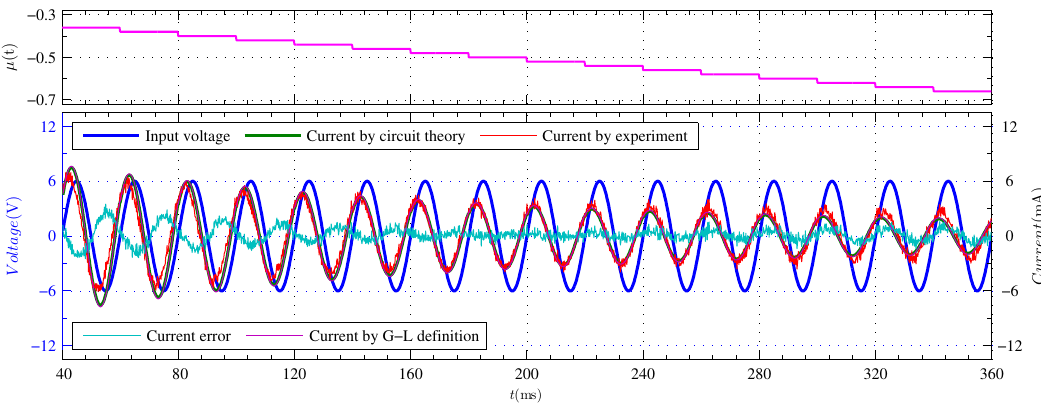
Figure 8. Experimental results of VSFF of continuous